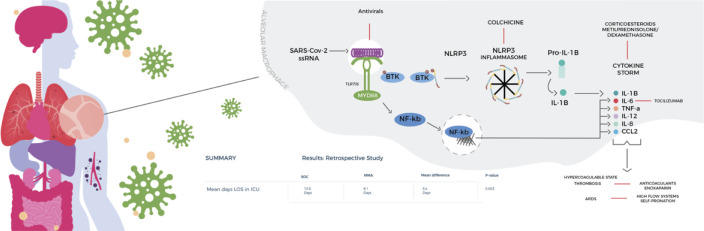
Multi-mechanism Approach (MMA).Includes widely available medications thought to target early immunomodulation, anticoagulation, and viral suppression to prevent catastrophic cytokine release syndrome and potential progression to respiratory failure, shock, and multi-organ dysfunction.